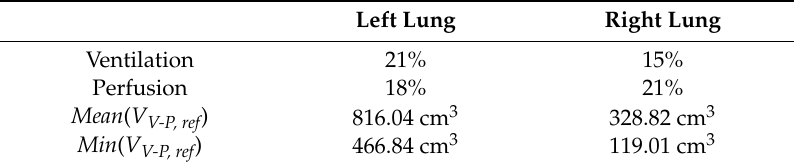
Table 3. Optimal segmentation thresholds and reference values of volume difference.